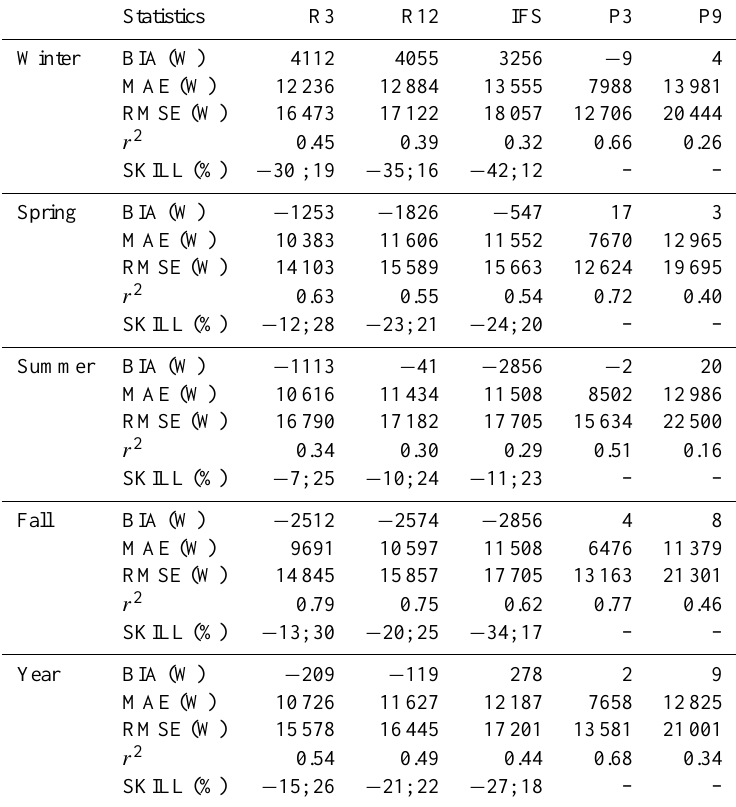
Table 1. Bias (BIA), mean absolute error (MAE), RMSE, coefficient of determination ( r 2 ) and skill score (SKILL) compared to the 3h (first number of the cell) and 9h (second number of the cell) persistence forecast for the wind power. P3 and P9 are the three and nine hours persistence